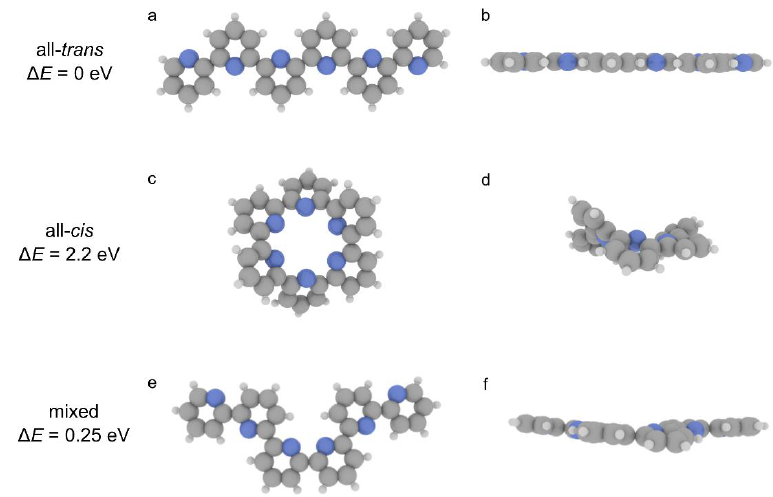
Figure 3. Gas-phase optimized geometries of pyridine oligomers in all- trans ( a , b ), all- cis ( c , d ), and mixed ( e , f ) configurations, respectively. ( a , c , e ) Top and ( b , d , f ) side views. Grey, blue, and white spheres represent carbon, nitrogen, and hydrogen atoms, respectively.